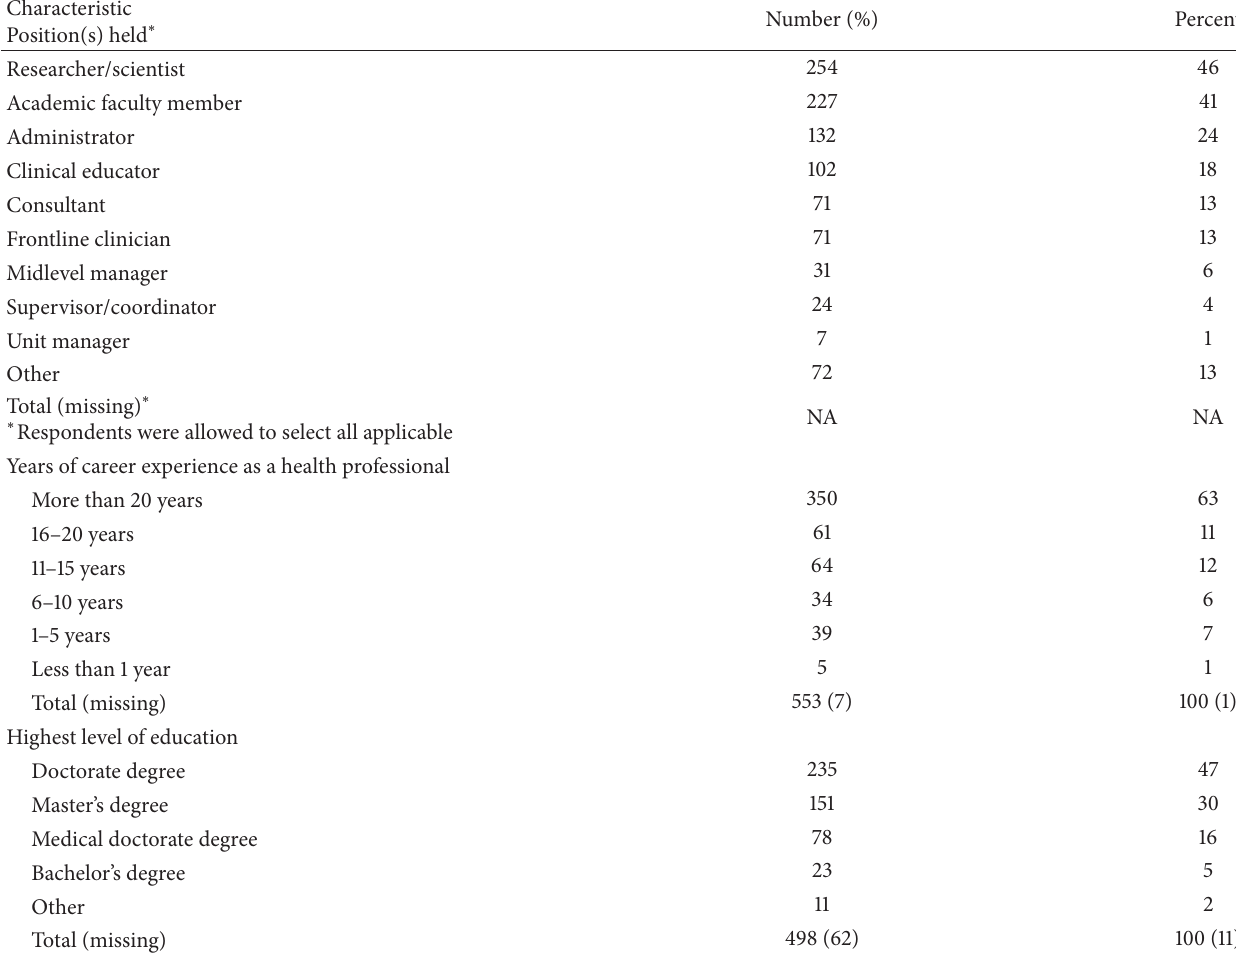
Table 2: Stakeholder survey respondent characteristics ( 𝑛 = 560